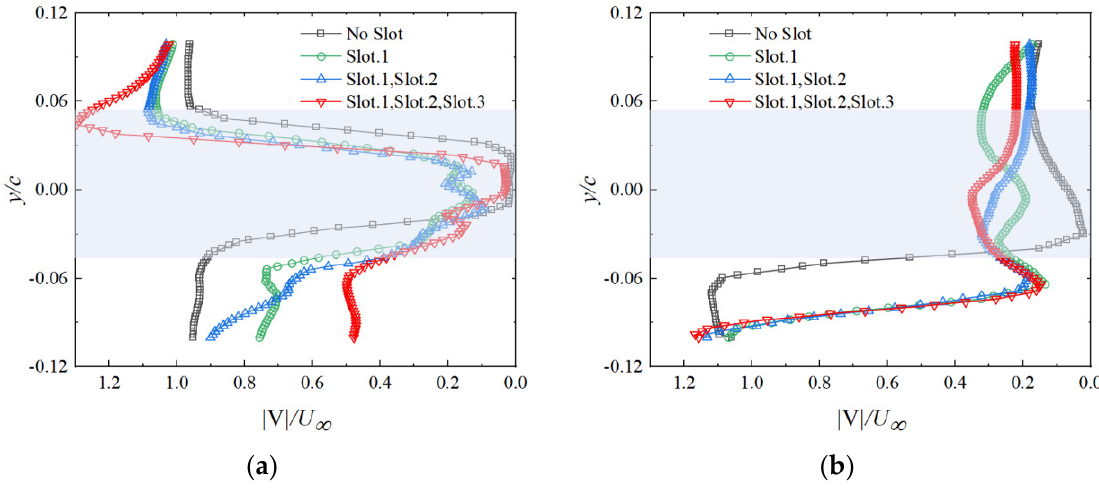
Figure 13. Near-field wake profiles with different number of slots ( U ∞ = 8 m/s, x/c = 1). ( a ) AoA = 0°. ( b ) AoA = 20°.